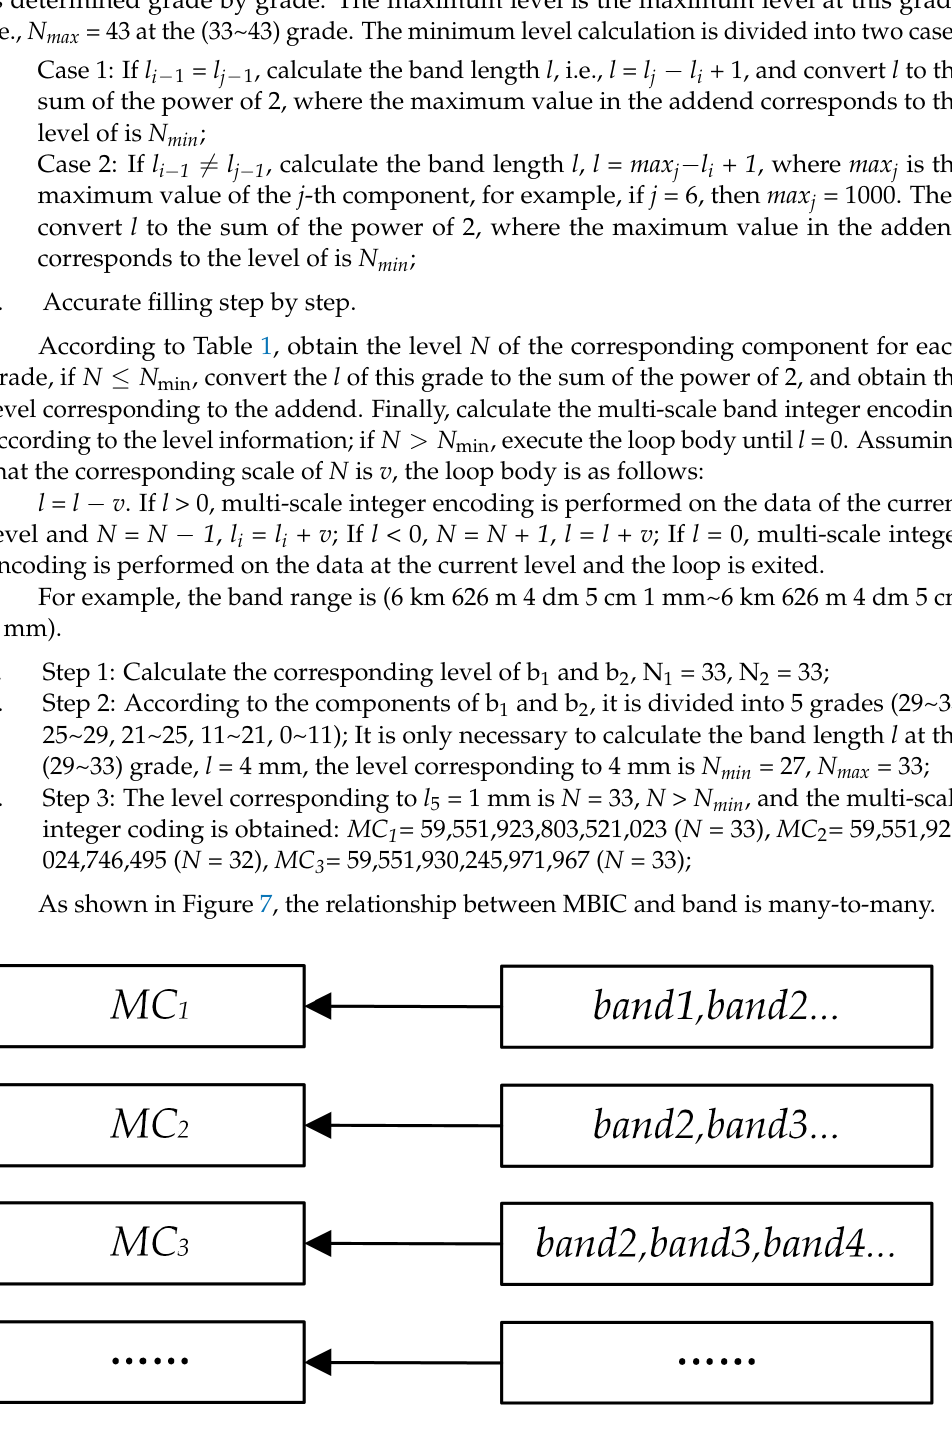
Figure 7. Correlation between MBIC and